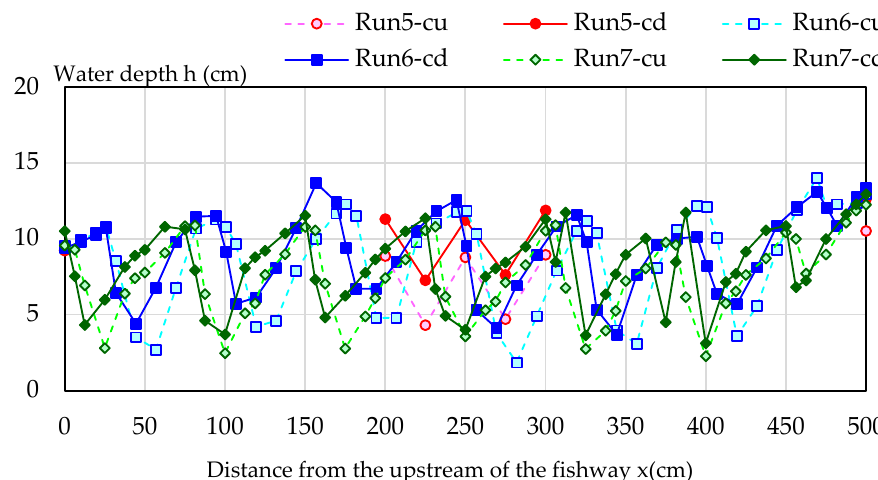
Figure 12. Water surface profile in the fishway (y = 2.5 cm; the lateral part of the fishway).